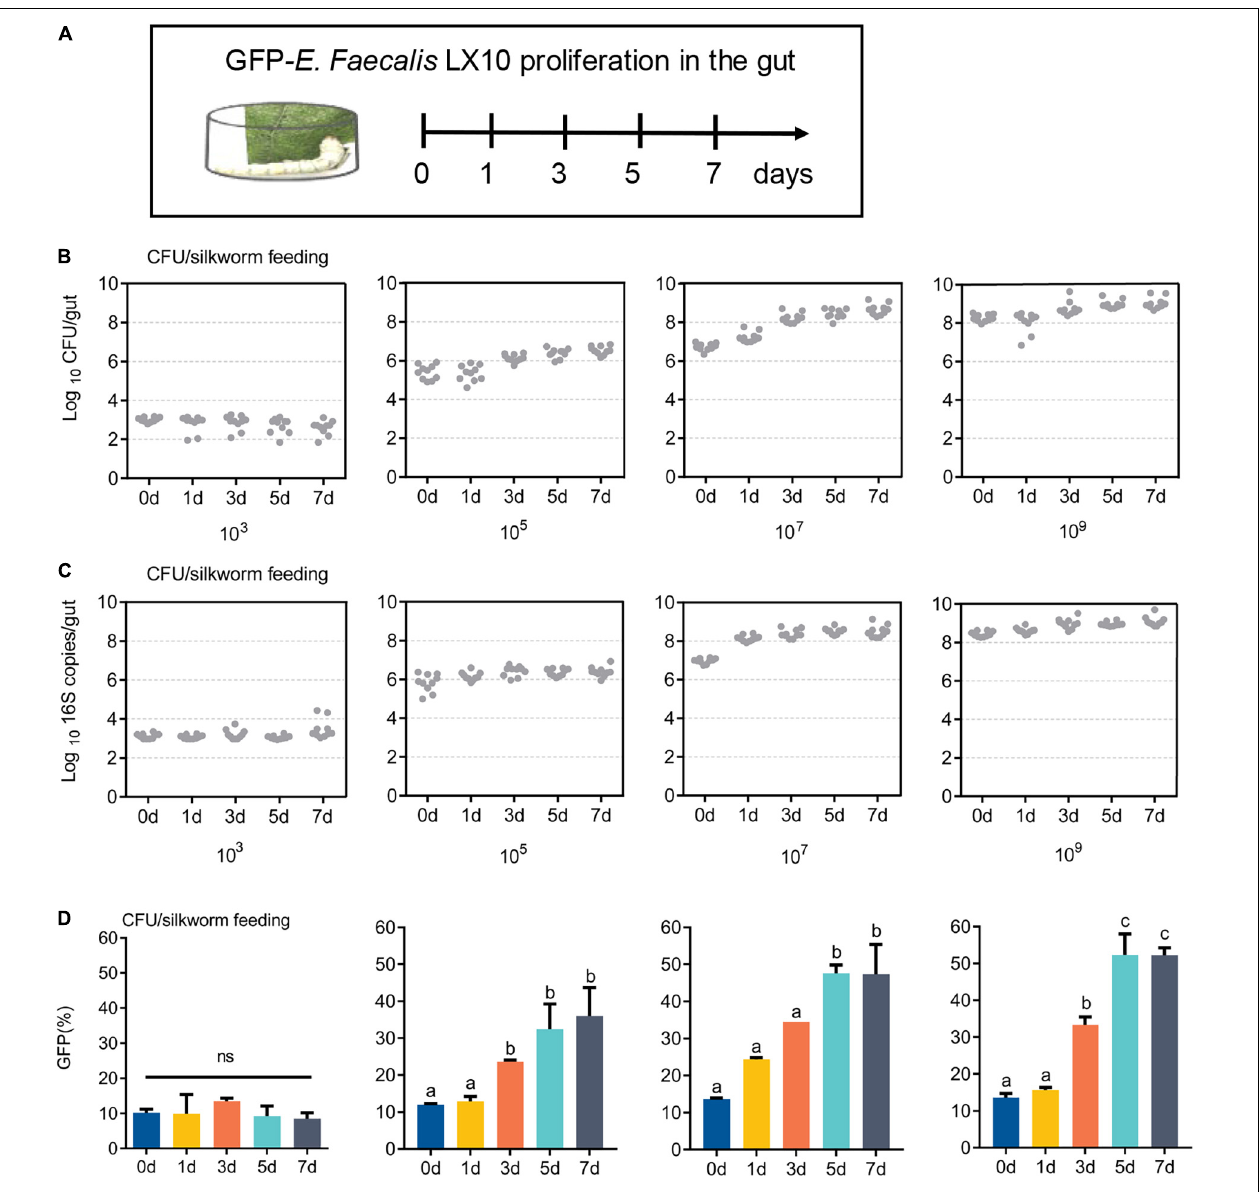
FIGURE 3 | GFP–expressing E. faecalis stably persists and proliferates in the gut of B. mori. (A) First-instar (day 1) B. mori were inoculated with different concentrations of GFP– E. faecalis (10 3 , 10 6 , and 10 9 CFU/mL). The silkworms were raised in cages, and feces were cleaned every 4 h, as shown in the scheme. (B) The number of CFUs in individual guts was assessed by plating at d 0, 1, 3, 5, and 7. Each dot represents one individual. (C) Absolute quantification of GFP– E. faecalis 16S gene numbers in gut samples (mean with 95% confidence intervals, n = 10). (D) A flow cytometry analysis (FACS) was performed on days 0, 1, 3, 5, and 7 to determine the percentage of GFP-positive cells. CFU, colony–forming unit. Statistically significant changes were determined by ANOVA and the post hoc Tukey honestly significant difference (HSD) test.